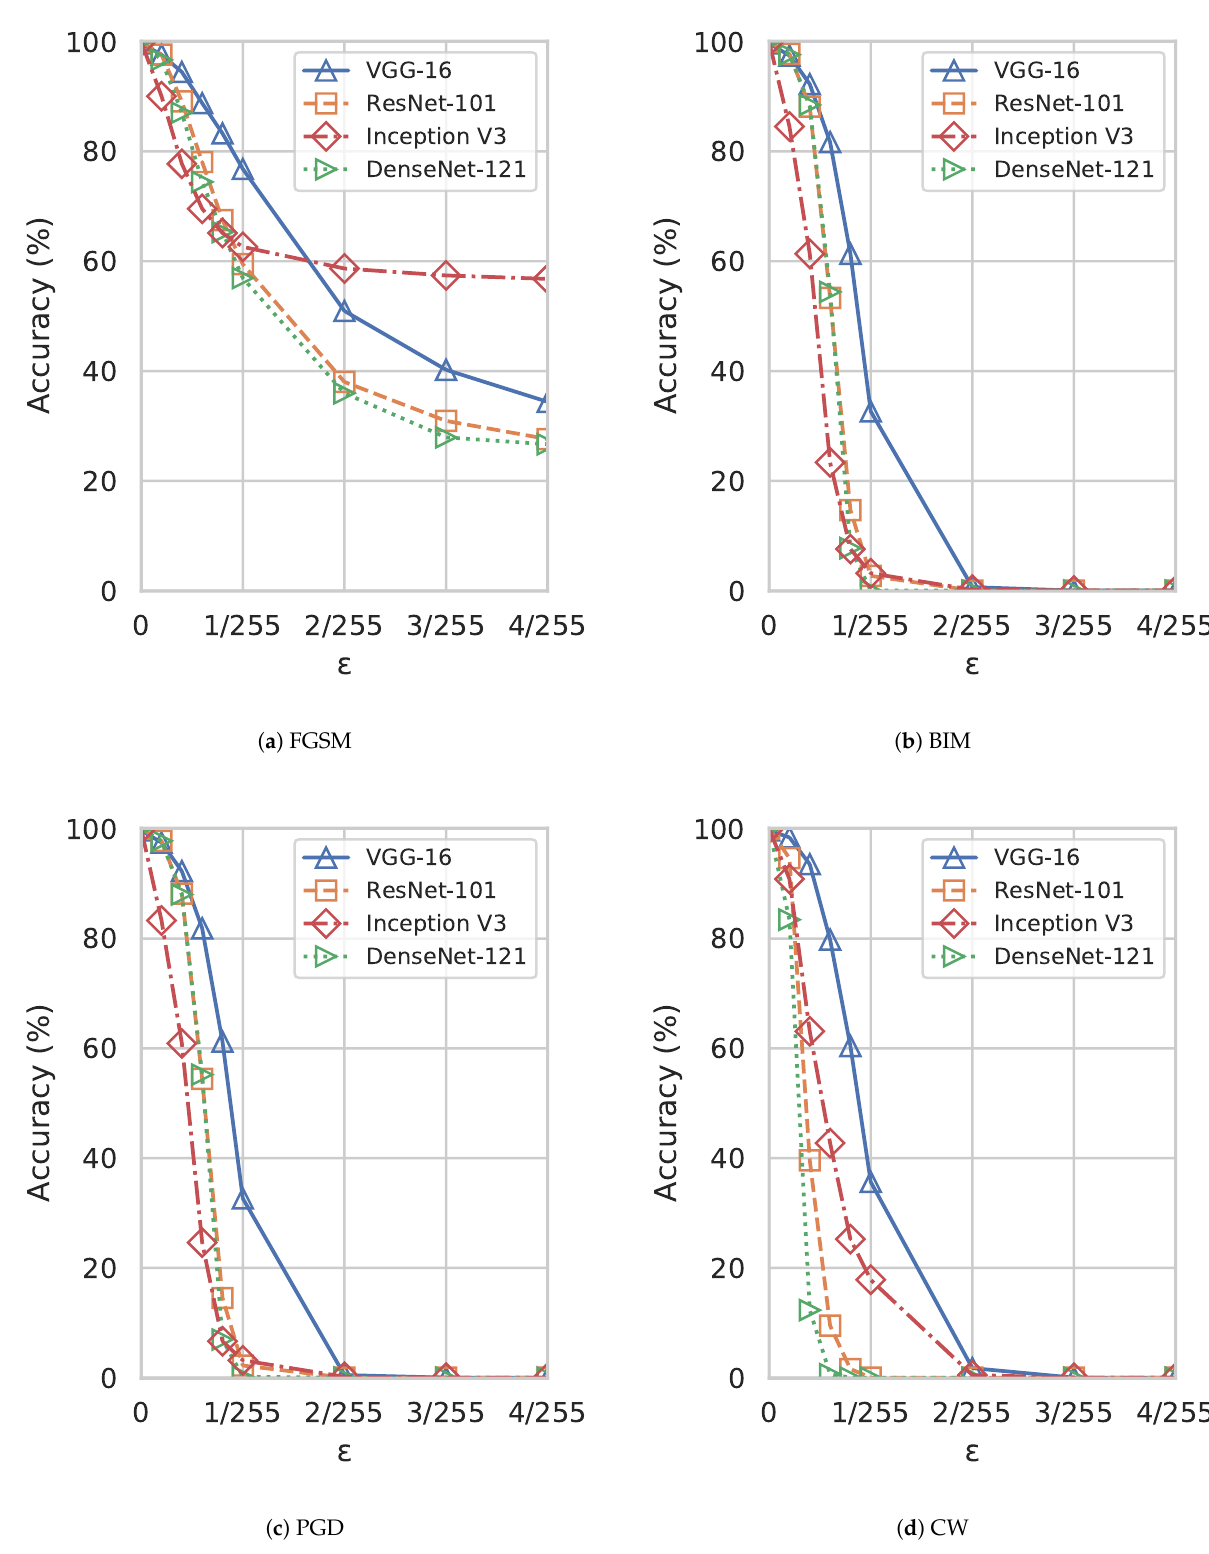
Figure 5. Performance comparison of four adversarial attacks on multi-class DNN models under different (cid:101)